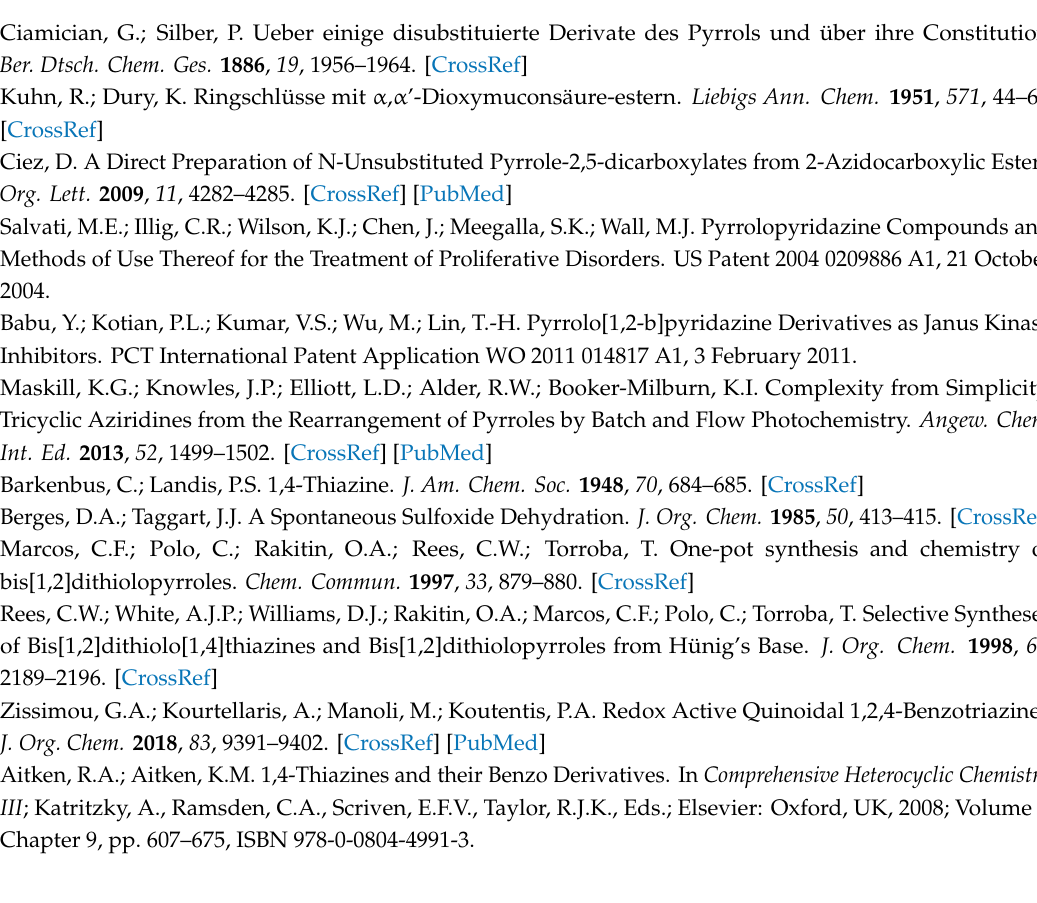
Supplementary Materials: The following is available online, Figure S1: UV–Visible spectrum of 1 in